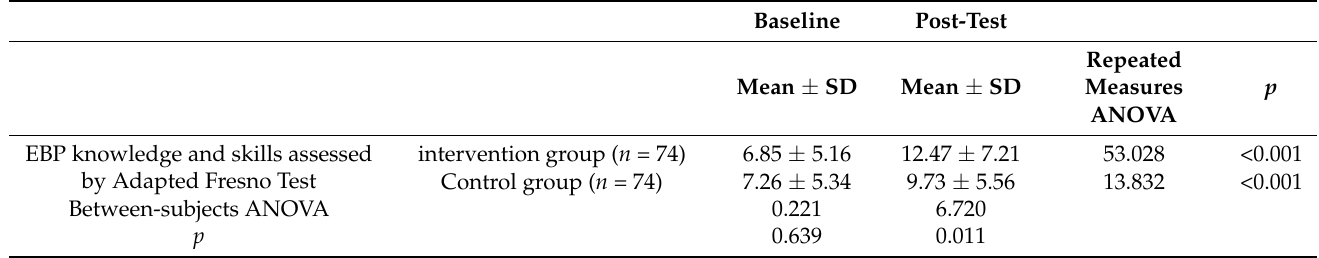
Table 3. Repeated measures ANOVA and between-subjects ANOVA—ITT